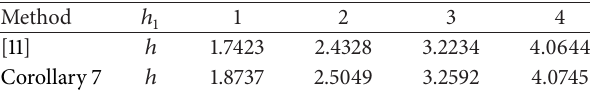
Table 3: Admissible upper bound ℎ for various ℎ 1